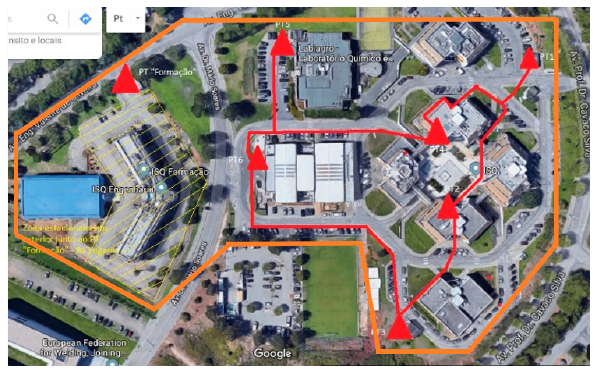
Figure 4. ISQ Campus.